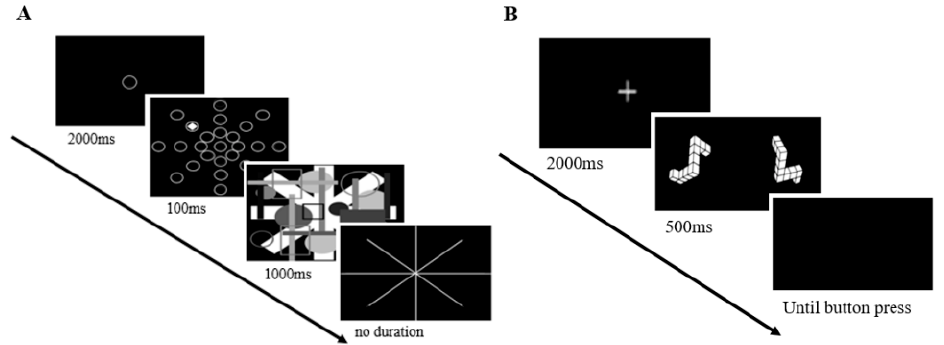
Figure 1. The experimental paradigms of ( A ) UFOV task and ( B ) mental rotation task are illustrated. ( A ) Participants had to identify the direction in which the target had been presented. ( B ) Participants had to determine whether the two given 3D-shaped targets were identical.